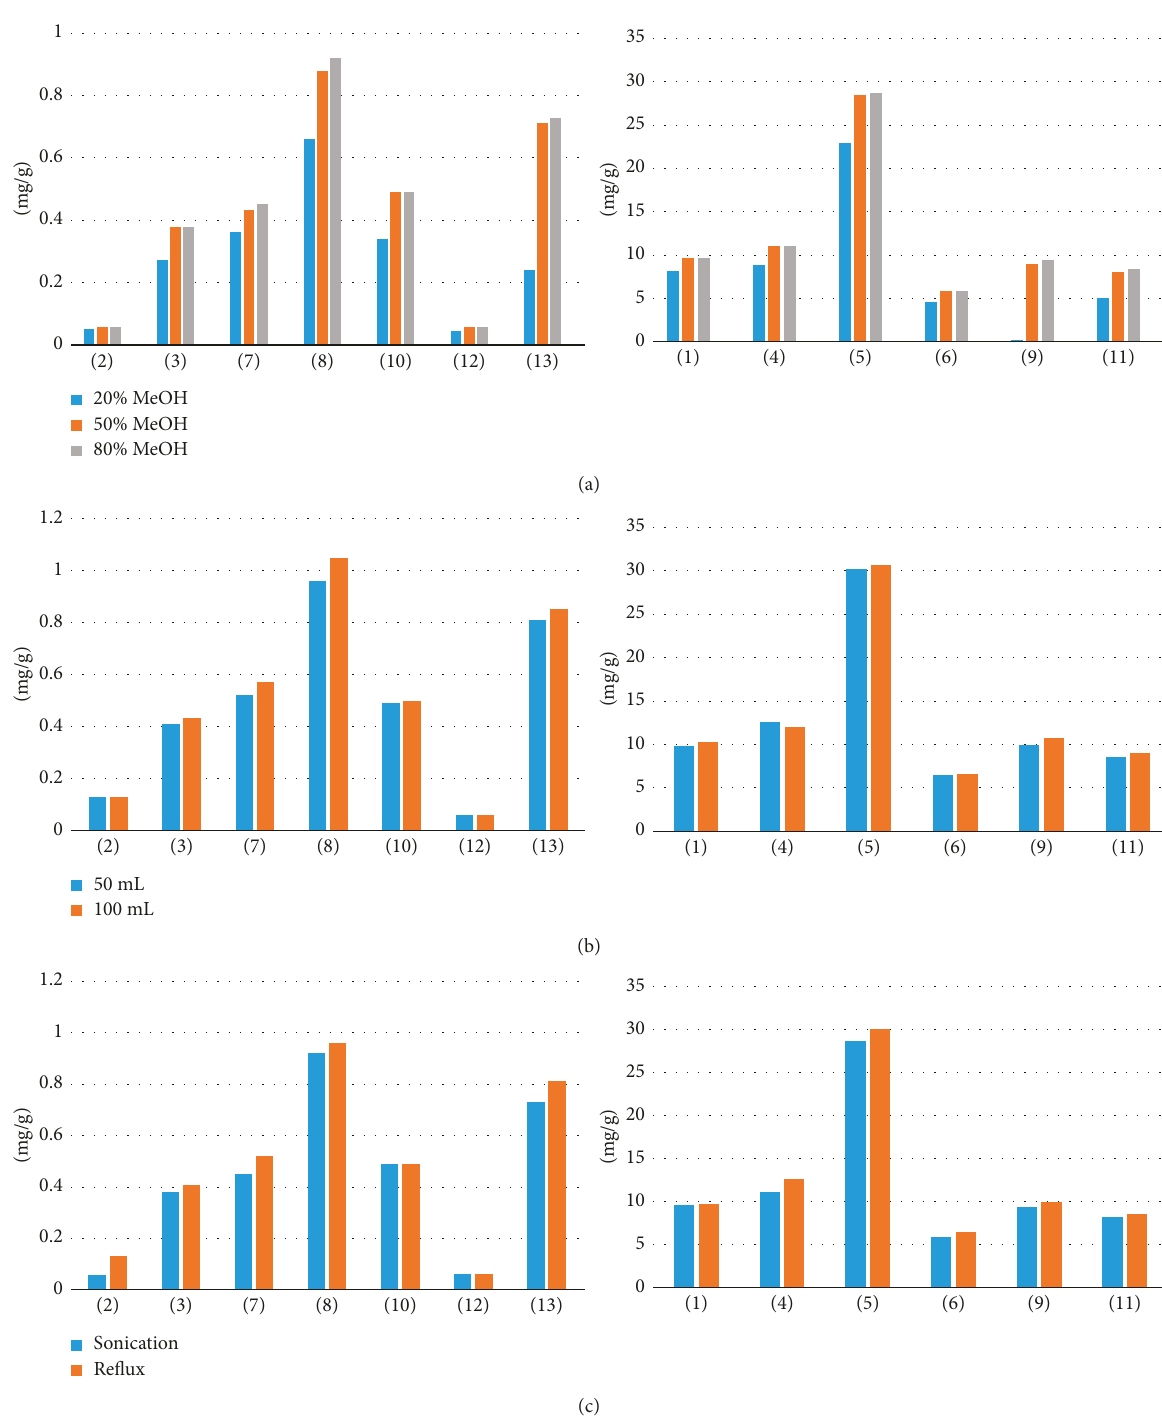
Figure 3: Efficiencies of the extraction for the nine compounds in SCRTusing different (a) extraction solvents, (b) volumes of the extraction solvent, and (c) extraction